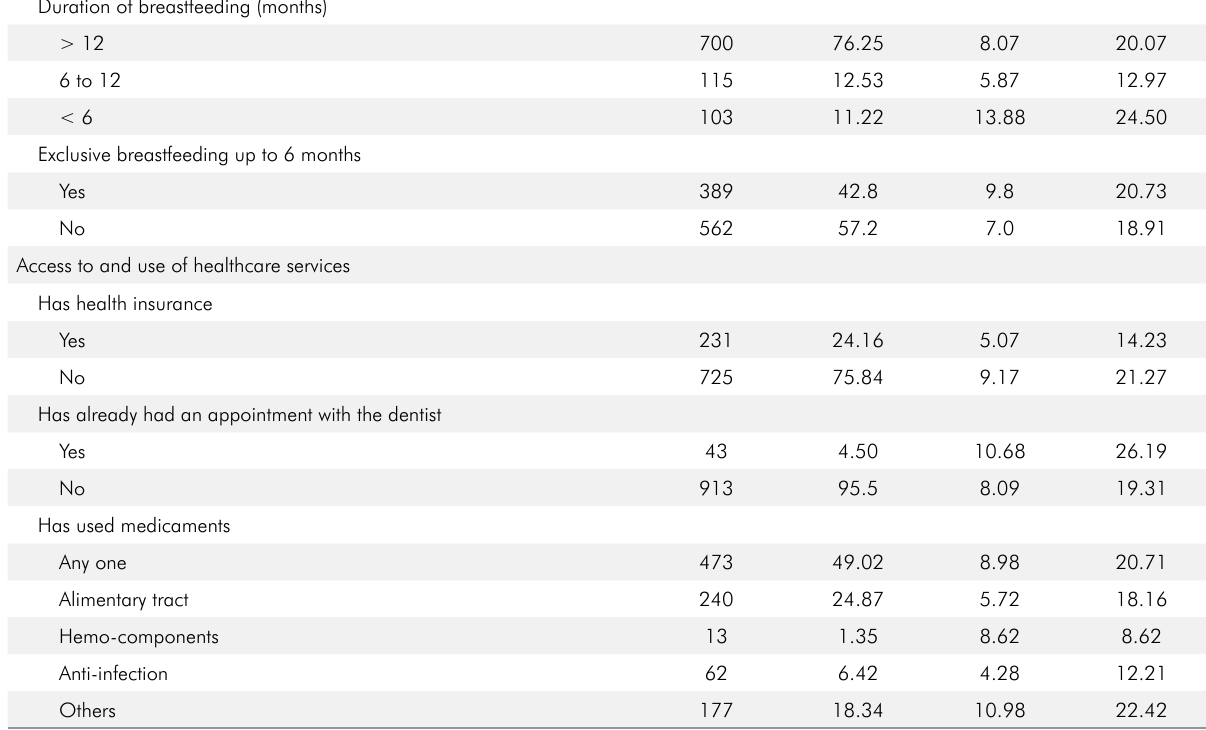
Table 3. Number of children with extrauterine DDE by dental group. São Luís, Brazil. Dental group